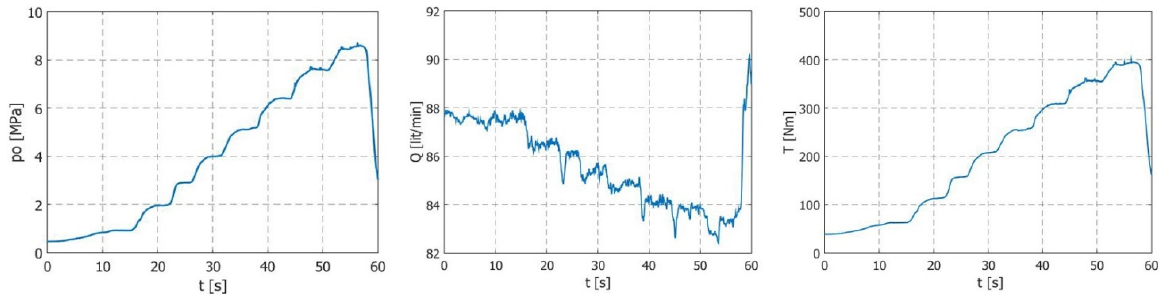
Figure 6. Diagram of dependence of the output pressure, working fluid’s flow rate, and torque of the pump shaft over time in the IR2 operating mode.